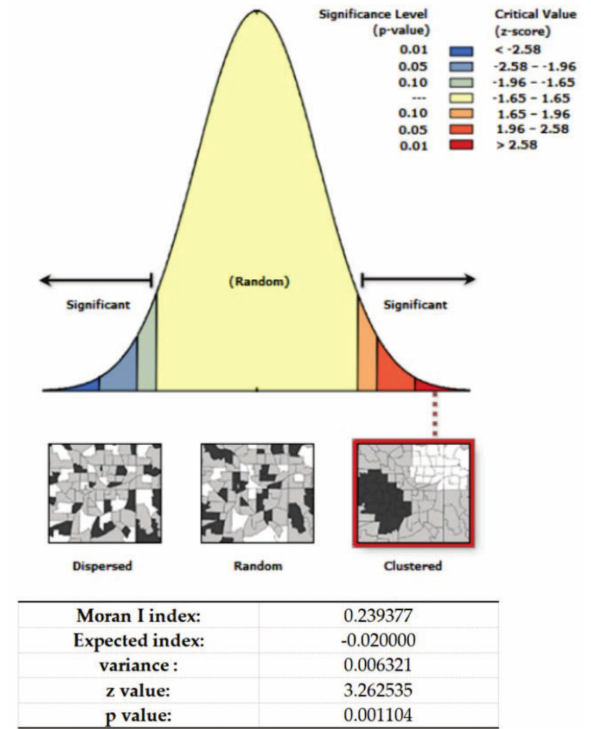
Figure 5. Spatial autocorrelation